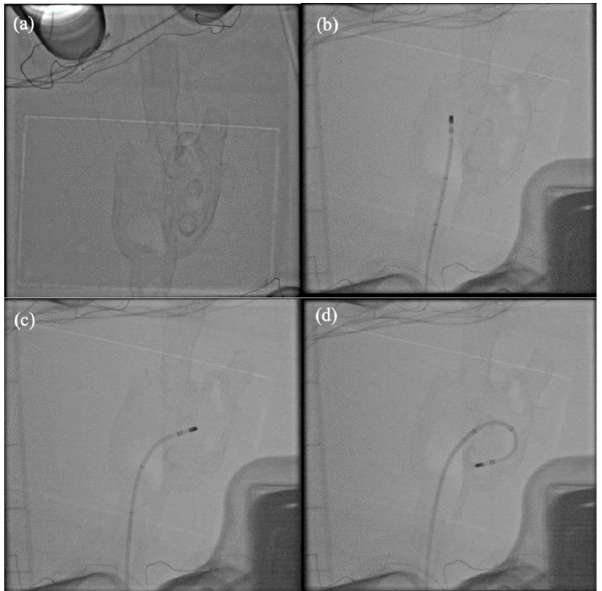
affected the internal coatings of the heart model and had no effect transmurally or on the outer coatings.